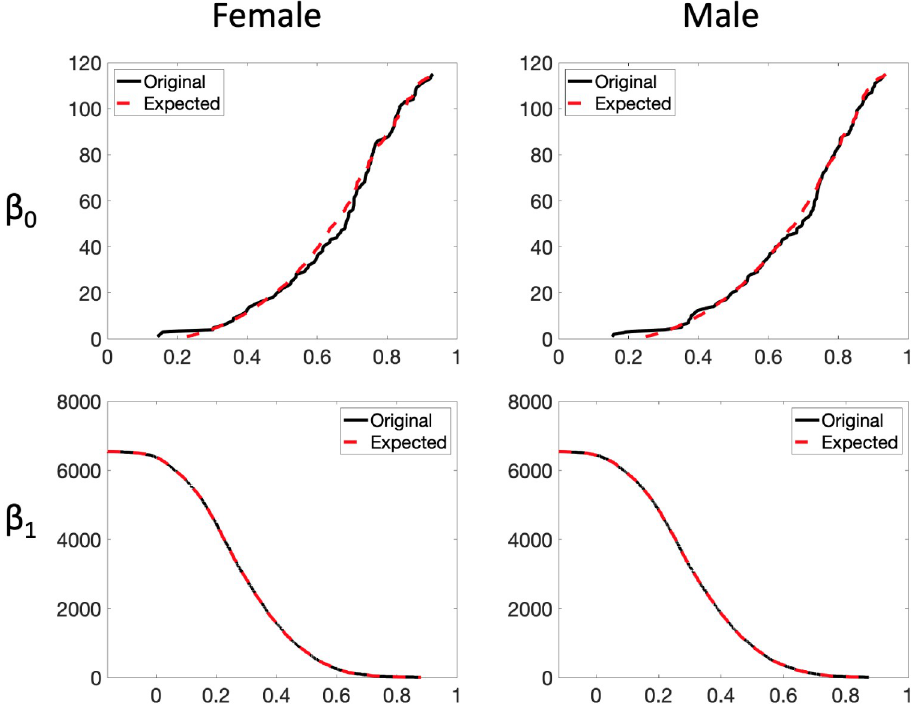
Fig 9. Plots of the original (solid black line) and estimated (dashed red line) β 0 (top) and β 1 (bottom) curves using expected birth and death values for the female (left) and male (right) brain